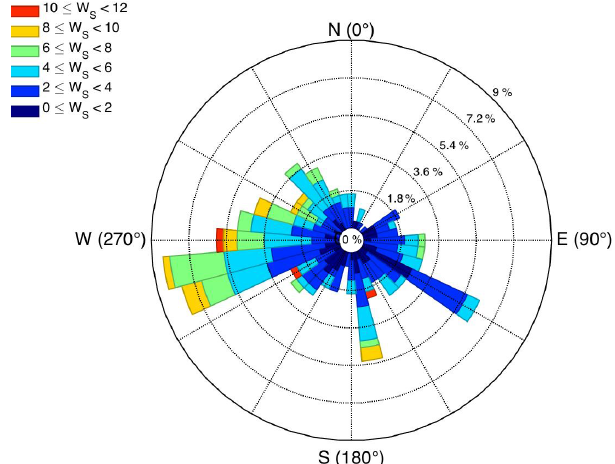
port for the period April 2015–April 2016 (using the mean of the afternoon hours for each day). The magnitude of wedges indicates relative frequency for each wind direction, and the wind speeds are indicated by color. These afternoon means were based on hourly reported measurements. For the hourly measurements, calm winds (<1.6ms − 1 ) were not categorized by direction and thus were not included in the afternoon mean. For the hourly measurements, calm winds (<1.6ms − 1 ) were reported as zero and were included in the afternoon